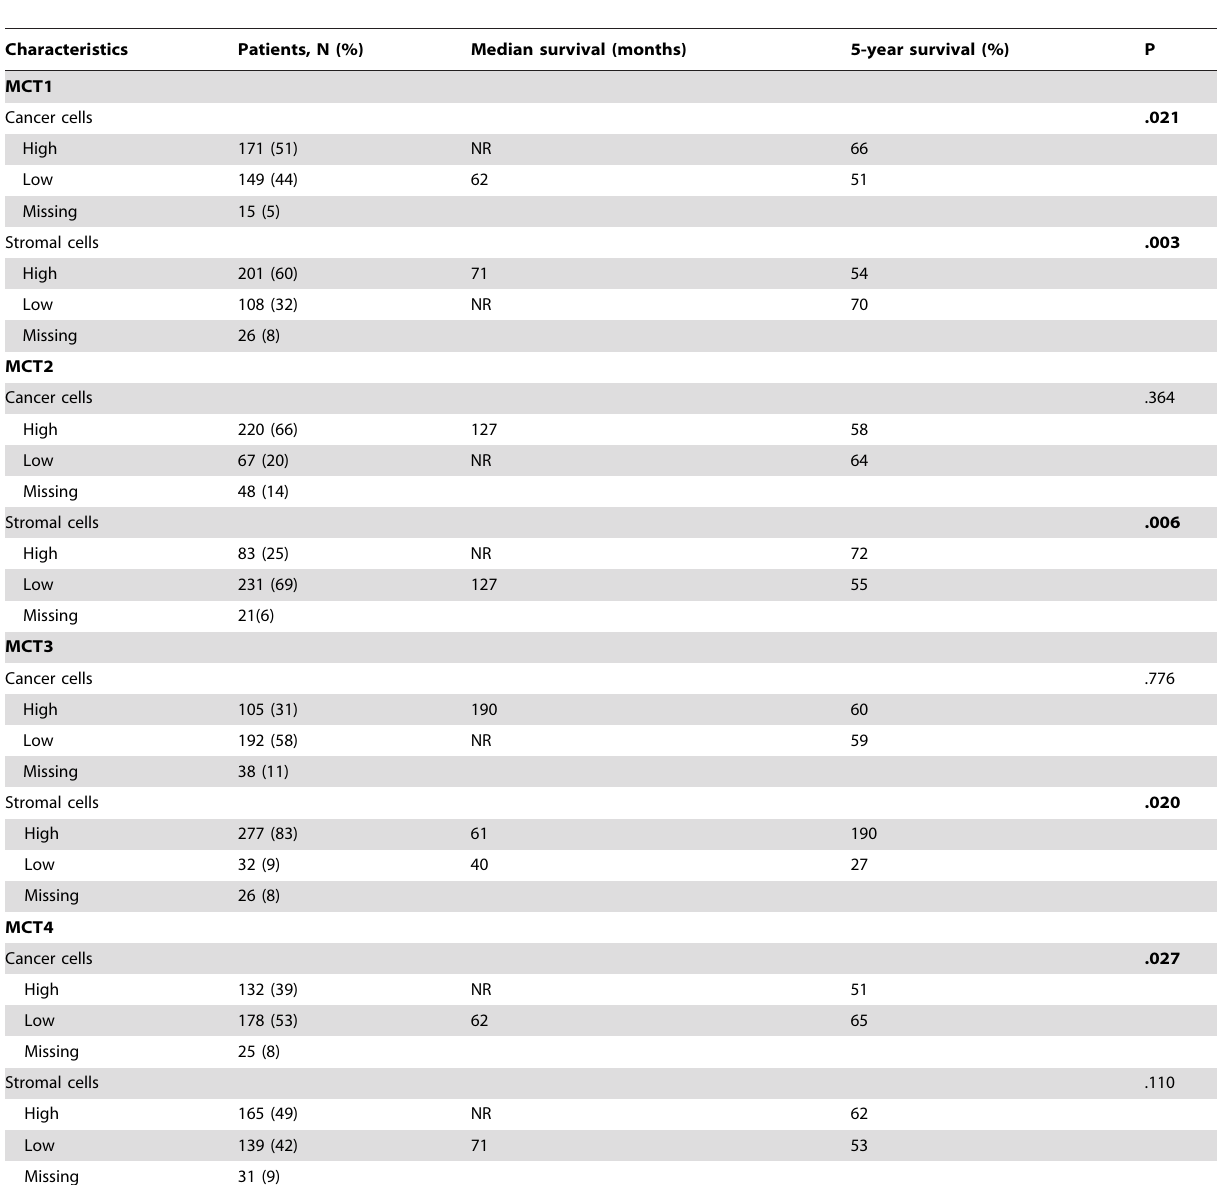
Table 2. Monocarboxylate transporters (MCT) 1–4 in cancer and stromal cells as predictors of disease-specific survival in 335 NSCLC patients (univariate analyses; log-rank test).